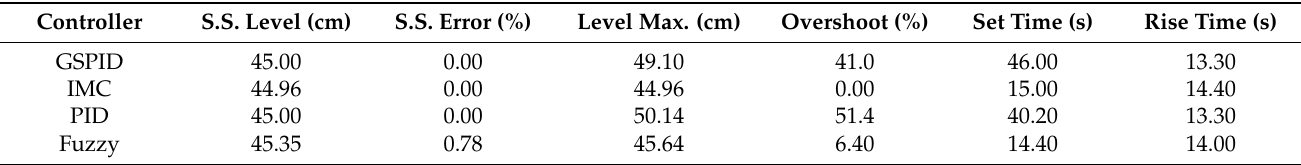
Table 5. Results for transitory response and stationary state (s.s.) error, 90 s computational simulation. Controller